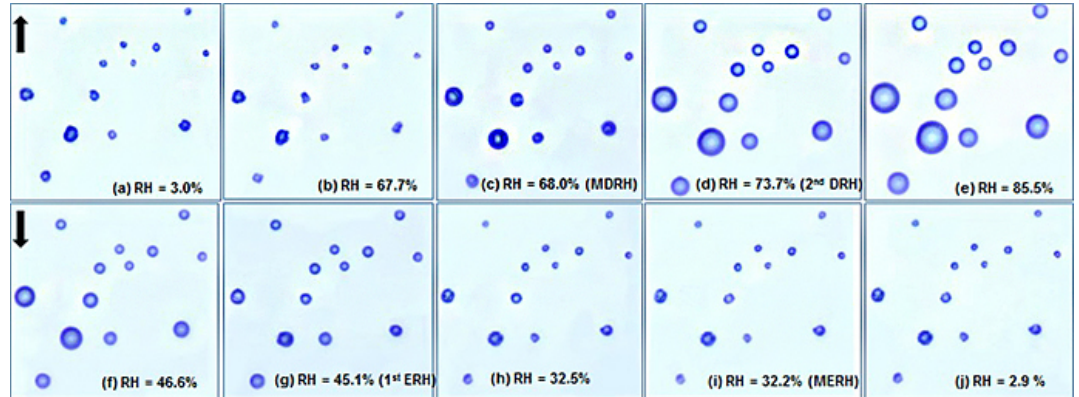
Figure 1. Optical images of NaCl–NaNO 3 particles with a mole fraction of X NaCl = 0 . 8, obtained during humidifying ( ↑ ) and dehydration ( ↓ ) processes for the same image